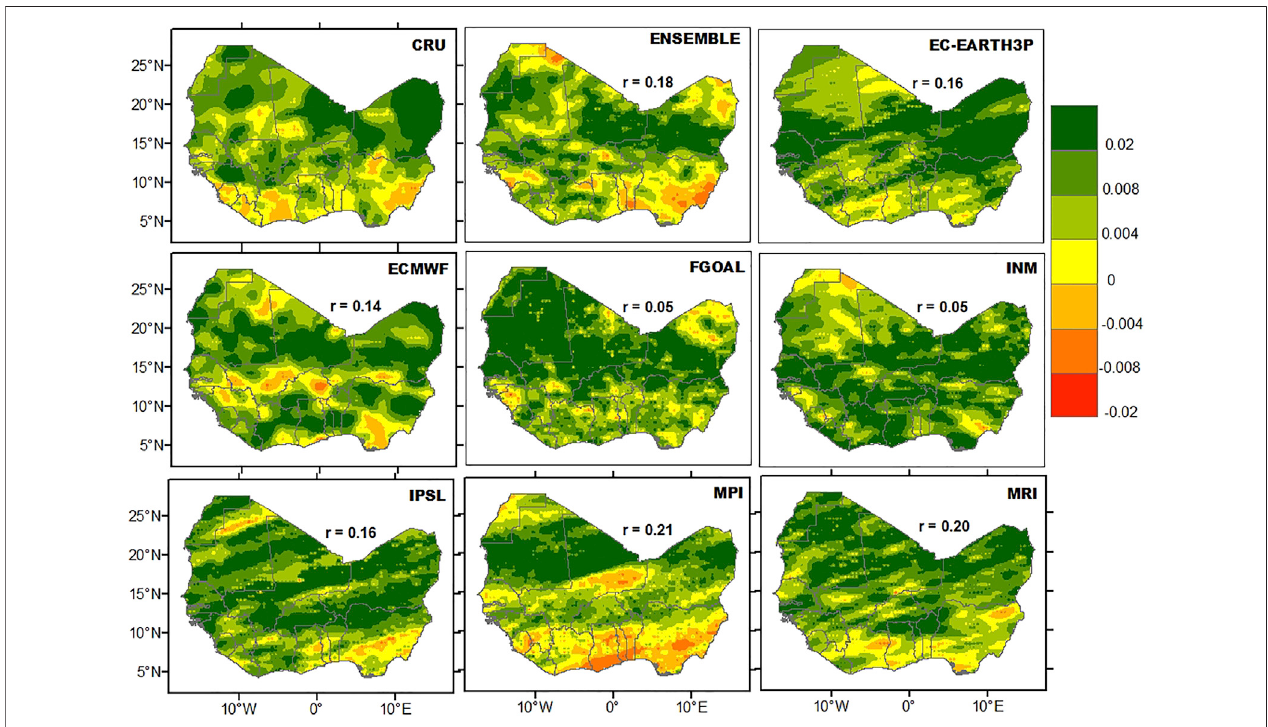
FIGURE 7 | Same as Figure 5 but for